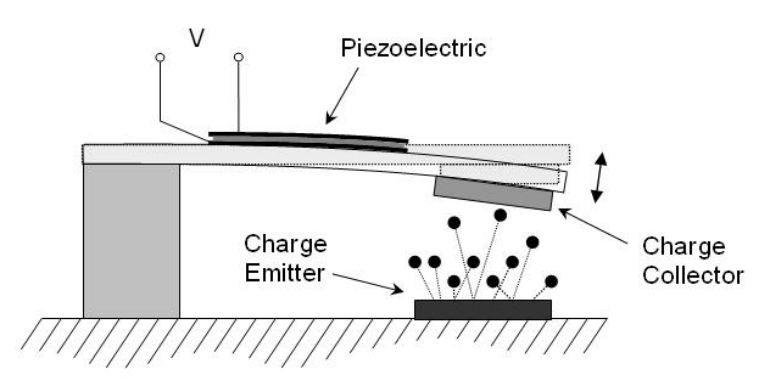
Figure 5. Radioisotope energy harvester.